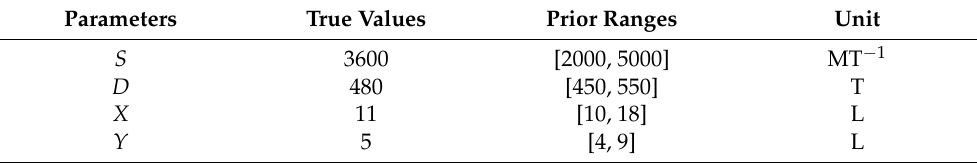
Table 2. The prior ranges and true values of unknown GCSPs for Case